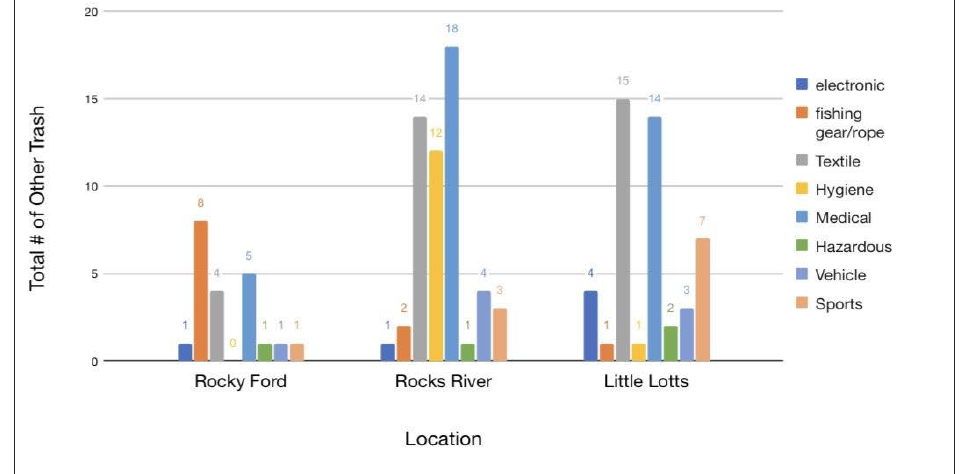
Figure 17. Trash Analysis — Other Commonly Found Trash during